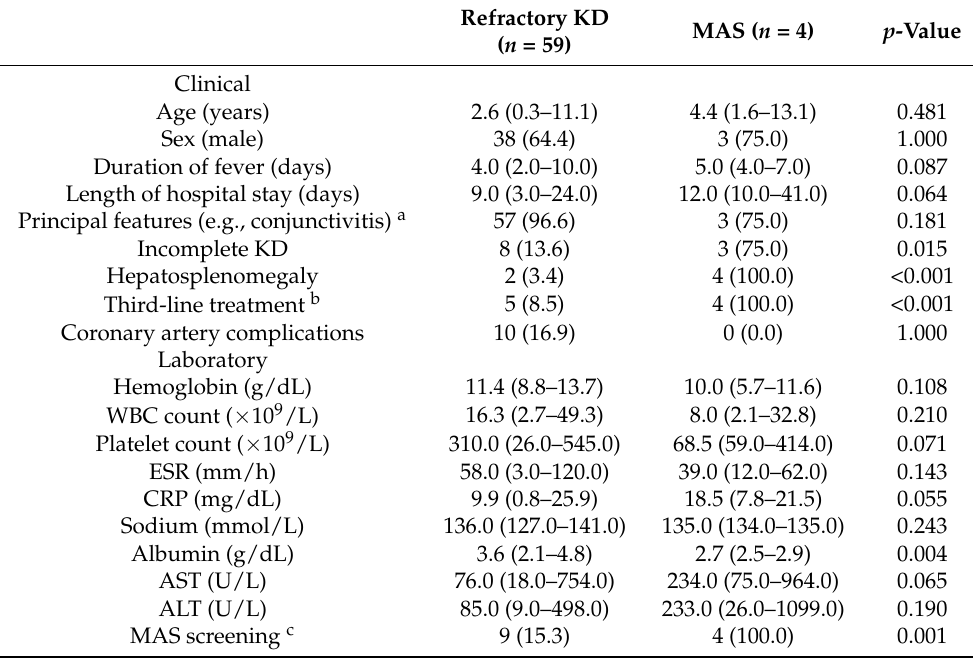
Table 1. Comparison of clinical and laboratory findings between